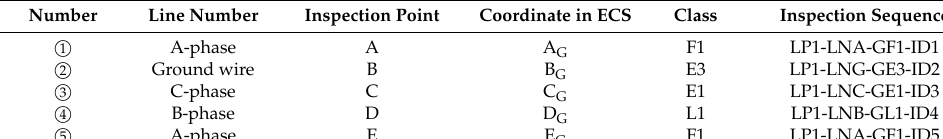
Table 3. Inspection sequences of waiting-inspection targets in k th span segment.